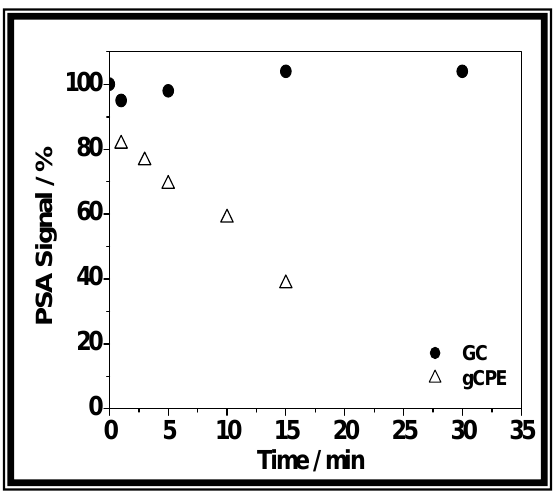
Figure 5. Chronopotentiometric guanine oxidation signal as a function of the hybridization time. The 100 % corresponds to the signal obtained in the absence of complementary sequence. Probe immobilization: for GCE, and for gCPE, 10.0 min at 0.200 V from a 10.0 ppm oligo(dG) 5.0 min at 0.200 from a 5.00 ppm oligo(dG) 21 21 using a pretreated gCPE (1.0 min at 1.70 V in the same probe solution). Hybridization conditions: different . Stripping conditions: initial times at 0.200 V in the presence of 10.0 ppm (GCE) or 20 ppm (gCPE) oligo(dC) 21 potential: 0.500 V; current: 8.0 µA; solution: 0.200 M acetate buffer pH